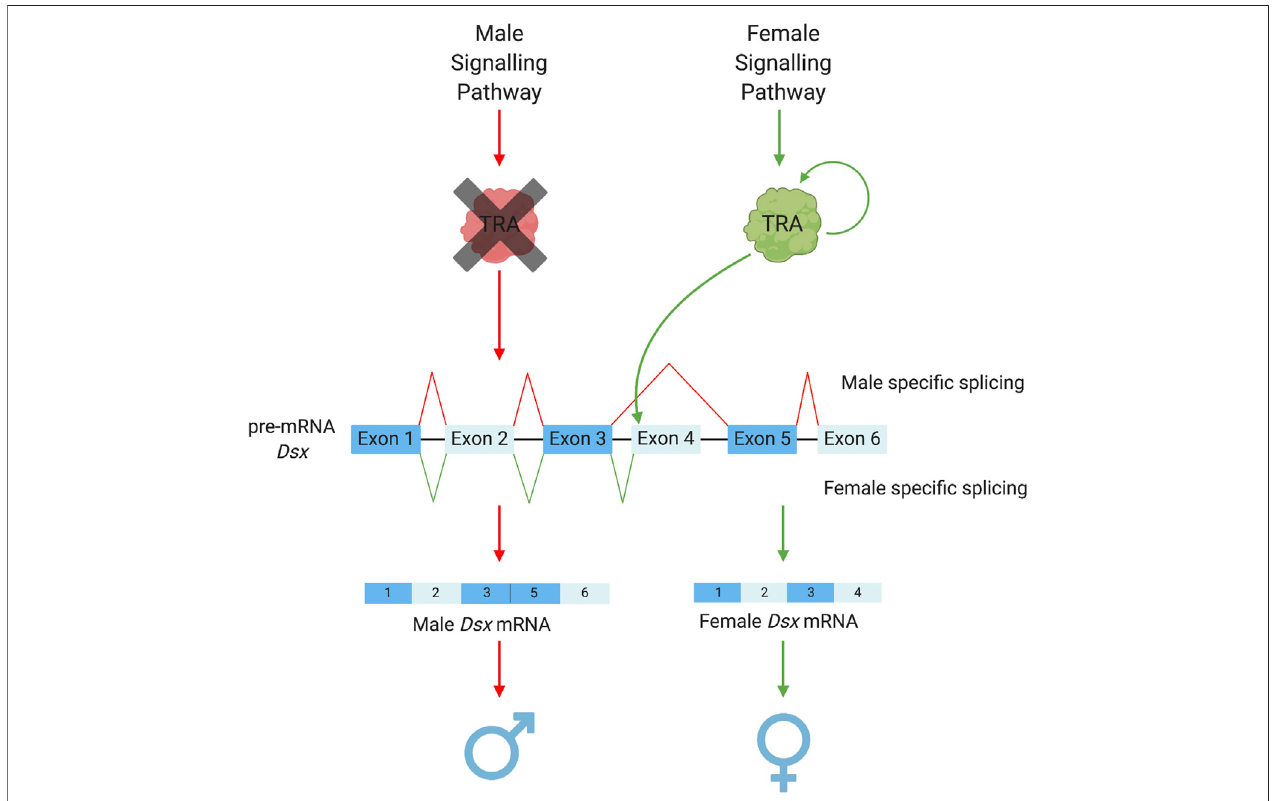
FIGURE 2 | Sex-speci fi c splicing patterns of doublesex. The conserved elements of the sex determination pathway that result in the alternative splicing of the pre- mRNA dsx. Depending on the upstream signalling pathways TRA is either present as a functional protein (in female development) or a non-functional protein (in male development). TRA acts as a splicing enhancer to promote the recruitment of the splicing machinery to the weak splice acceptor prior to exon 4 of the dsx pre-mRNA (Shukla and Nagaraju, 2010). This allows for the retention of exon 4 in the mRNA resulting in the female version of dsx. Doublesex exon numbers vary among species with the use of splicing to retain or remove sex-speci fi c exons remaining constant, Ceratitis capitata pathway illustrated in this fi